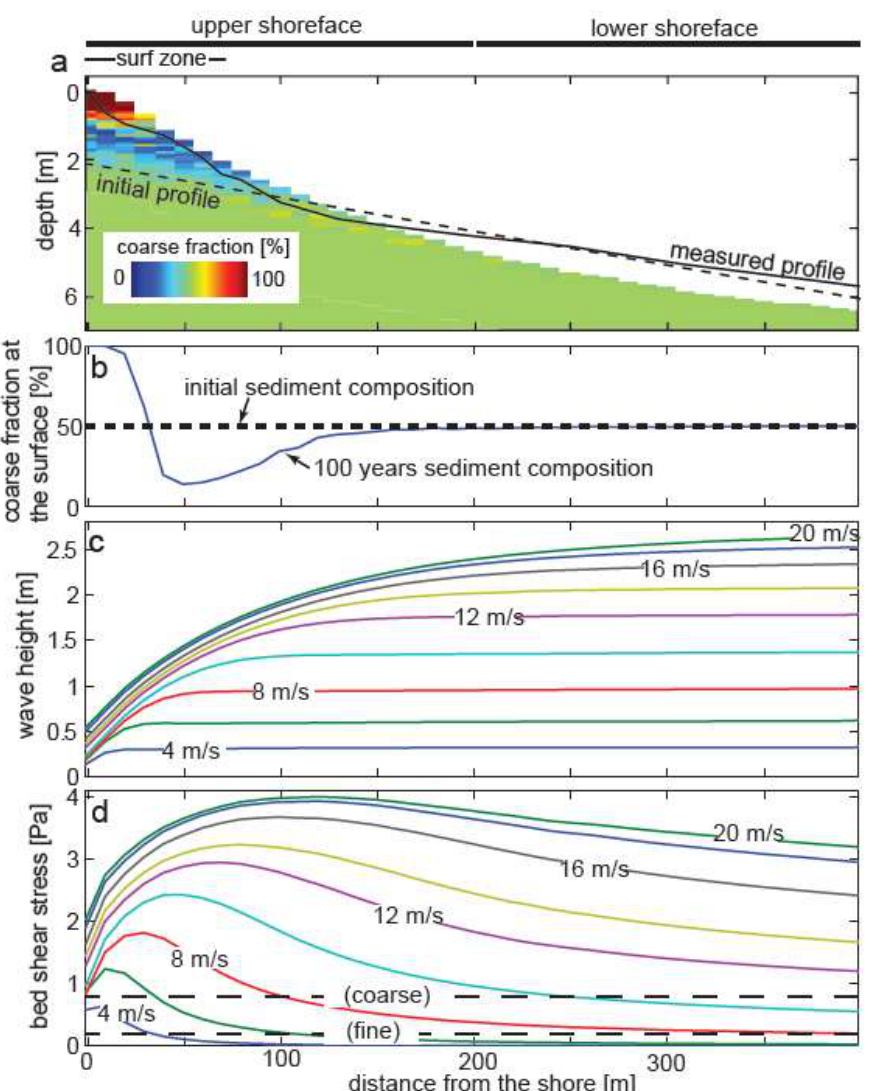
Figure 7. Predicted wave hydrodynamics and morpho-stratigraphy evolution at the Pigeon Cay transect. ( a ) Bed profile after 100 years of morphological evolution. Two classes of sediments were simulated (250 and 1000 µm); colors indicate the fraction of coarse material (1000 µm). The limit of the surf zone is defined as the point where the water depth reaches 2.5 m, and coincides with the point where waves generated by 12 m/s winds break. ( b ) Fraction of coarse material at the bed surface. ( c ) Wave height for different wind speeds. ( d ) Bed shear stress for different wind speeds. Dashed lines indicate the critical shear stress for motion of a grain size of 250 µm, equal to 0.2 Pa, and 1000 µm, equal to 0.8 Pa.